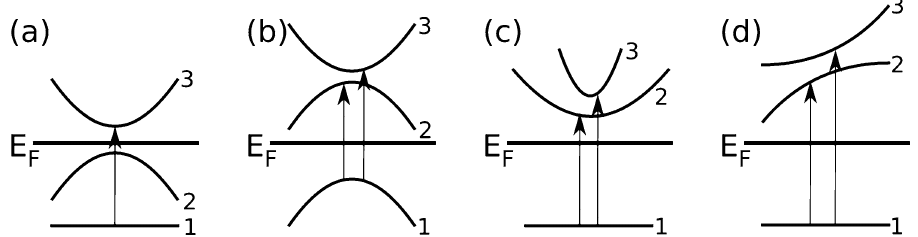
Figure 9. One dimensional sketches of possible MO transitions. In ( a ) transition 1 → 2 will not contribute to MO as both bands are occupied, thus transition 1 → 3 will not be weakened. This corresponds to the ideal case. In ( b ) the gradient of the energy difference (see Eq. (1)) causes transition 1 → 2 to be strong and narrow in energy and dominate over transition 1 → 3 which is weak and wide. This is the prime example of large JDOS discrepancy. In ( c ) and ( d ) we demonstrate that any assymetry in the hybridizing bands leads to non-zero total MO effect due to different